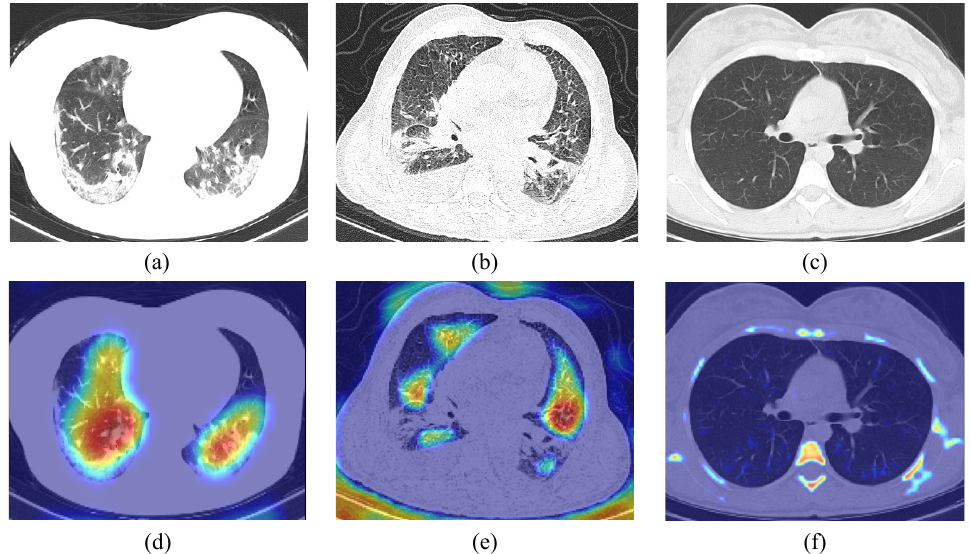
Figure 10. Grad-CAM visualization. ( a – c ), respectively, represent COVID-19, pneumonia, and normal CT scan; ( d – f ), respectively, represent heatmap of ( a – c ).